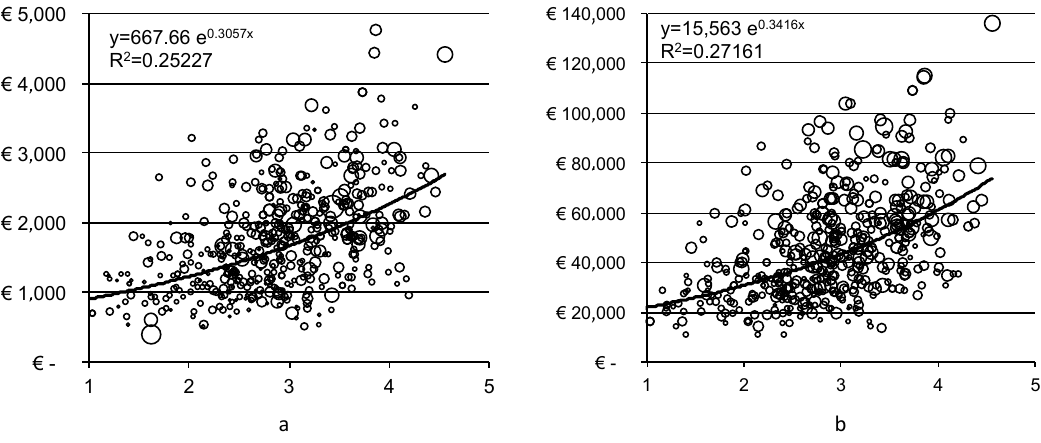
Figure 5. Relationship between ( a ) price euros/sqm (y-axis), or ( b ) price euros/room (y-axis) and the overall quality k ∗ of properties (x-axis).